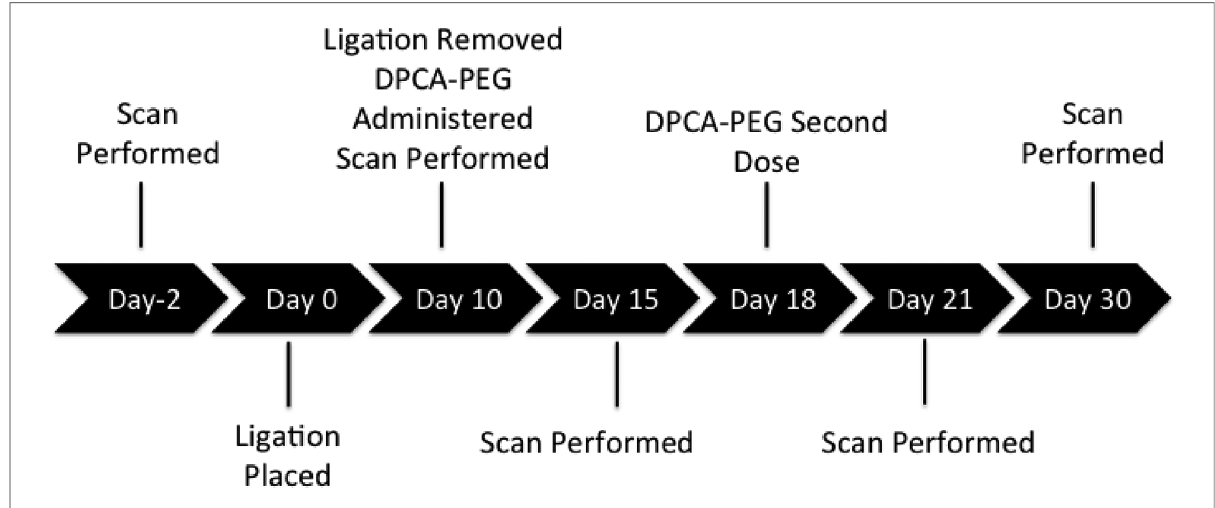
FIGURE 7 Timeline of